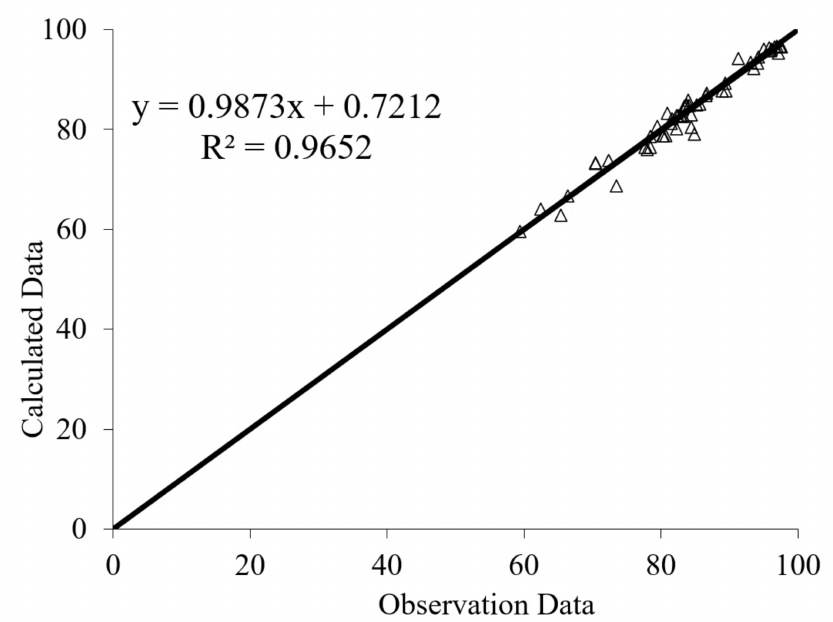
Figure 17. Predicted versus experimental values of residual CS after immersion in H 2 SO 4 solution. Table 9. Final weights and bias values of the optimum ANN-PSO model 7-5-6-2. IW b1 −